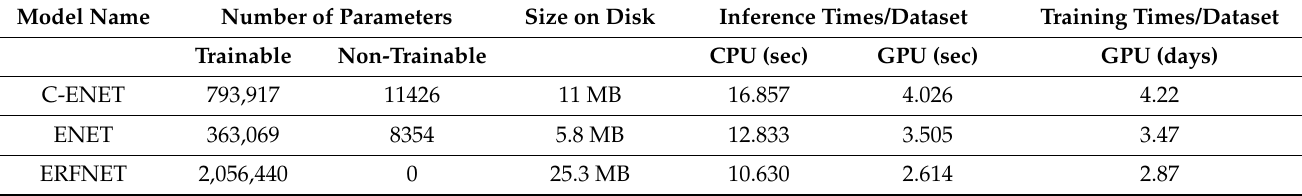
Table 5. Comparison of computational complexity and performance of DL